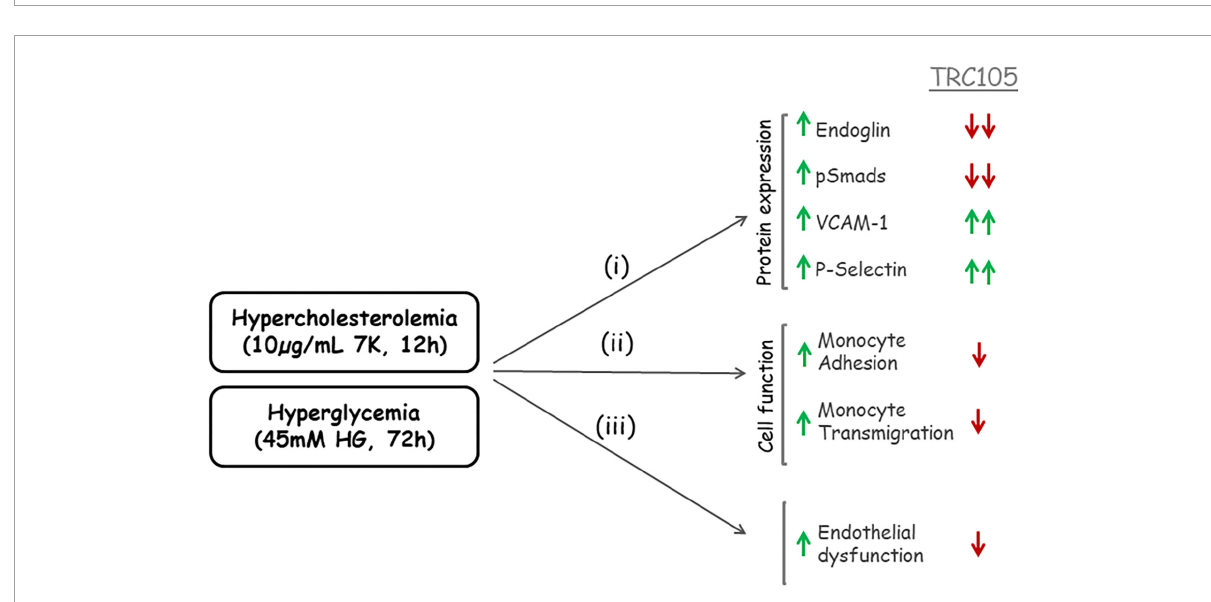
FIGURE10 Schematic representation of TRC105 effects on human aortic endothelial cells under hypercholesterolemic (treated with 10 µ g/ml 7-ketocholesterol [7K] for 12 h) or hyperglycemic (treated with 45 mM high glucose [HG] for 72 h) conditions. Hypercholesterolemia or hyperglycemia stimulates (i) protein expression of Eng, pSmads, vascular cell adhesion molecule 1 (VCAM-1), and P-selectin in endothelial cells; and (ii) monocyte adhesion to endothelial cells and monocyte transmigration through endothelial cell monolayers. The overall effect of hypercholesterolemia or hyperglycemia is endothelial dysfunction (iii). TRC105 inhibits 7K- and HG-induced expression of Eng and pSmads, while enhancing even further expression of VCAM-1 and P-selectin. TRC105 also inhibits 7K- and HG-induced adhesion of monocytes to endothelial cells and transmigration of monocytes through the endothelium, regardless of increased expression of cell adhesion